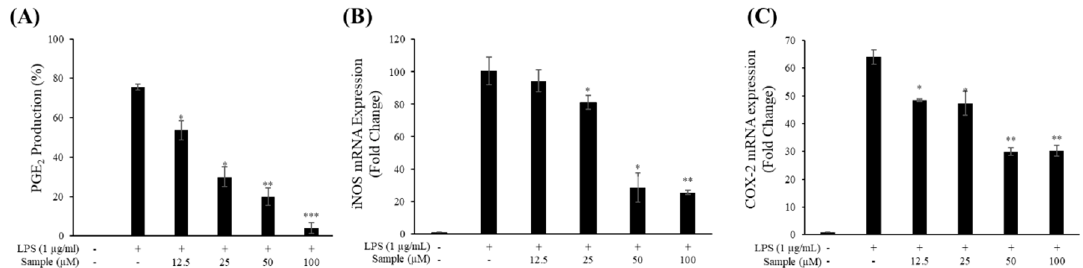
Figure 3. Effects of FMP on prostaglandin-E 2 (PGE 2 ) production and mRNA levels of inducible-nitric oxide synthase (iNOS) and cyclooxygenase-2 (COX-2) in LPS-stimulated RAW 264.7 cells. ( A ) The production of PGE 2 was assayed in the culture medium of cells stimulated with LPS (1 µg/mL) for 24 h in the presence of FMP (12.5, 25, 50, and 100 µM) by ELISA; ( B , C ) mRNA levels of iNOS and COX-2 were determined by qRT-PCR. The data represent the mean ± SD of triplicate experiments. * p < 0.05, ** p < 0.01, *** p < 0.005 versus LPS alone.